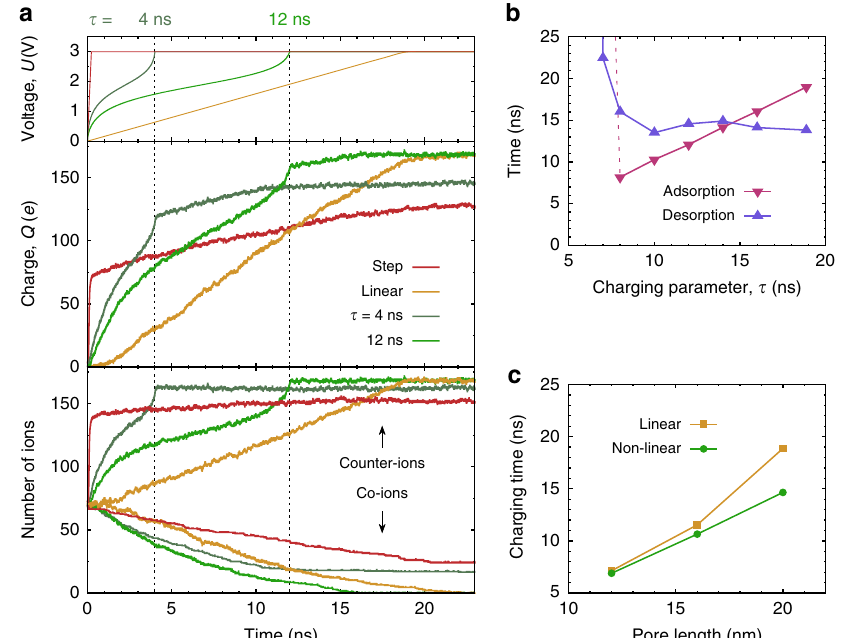
Fig. 3 Non-linear sweeps versus step-voltage and optimal linear sweep. a Potential U ( t ) applied to a nanopore with respect to the bulk electrolyte (top), accumulated charge (middle) and the number of ions (bottom) for step-voltage, optimized linear and two non-linear sweep functions from MD simulations. U ( t ) for non-linear sweeps have been obtained via fi tting the MD data to the stretched exponential (see eq. (3) and Fig. 2), and τ is an ‘ optimization ’ parameter, see eqs. (5) and (6). For comparison of the non-linear and linear sweeps with the same stopping time t = 12 ns, see Fig. S9. b Counterion adsorption and co-ion desorption times as functions of parameter τ (see Figs. S10 and S11). The optimal τ value, τ opt , corresponds to τ at which the adsorption and desorption times intersect. c Charging times for linear and non-linear sweeps as functions of pore length. In a and b , the pore length ℓ = 20 nm. In all plots, the ion diameter a = 0.5 nm and the pore width w = 0.6 nm.